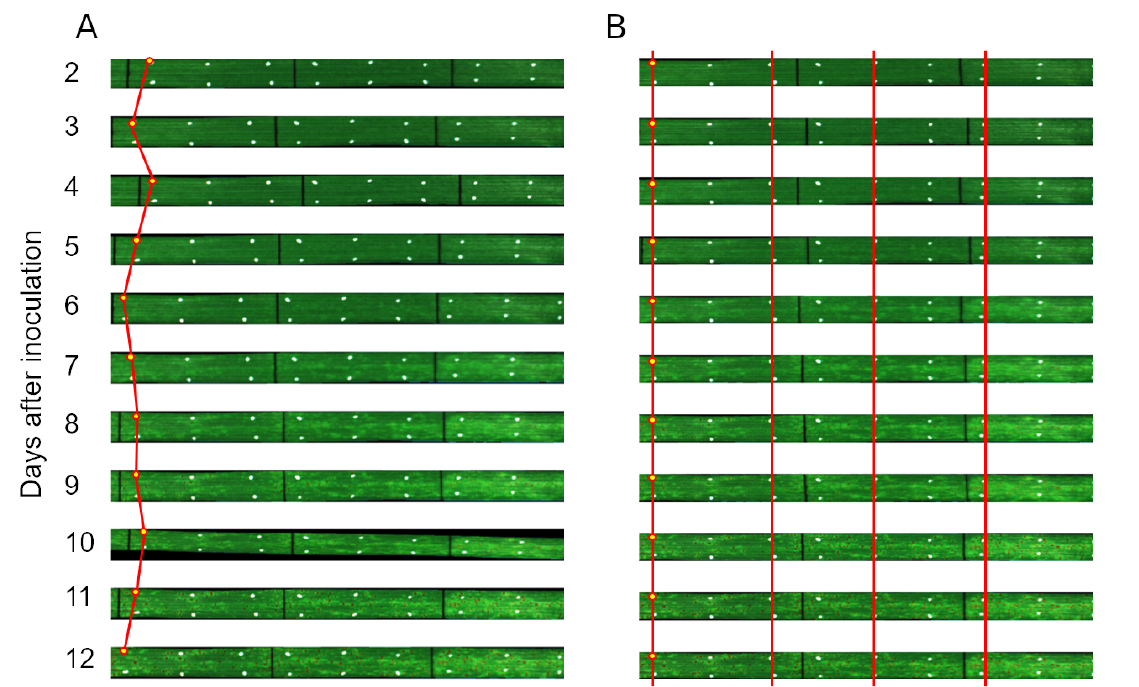
Figure 4. Effect of the spatial referencing. ( A ) shows the time series of unaligned hyperspectral images and ( B ) the same time series after the application of the proposed algorithm. To illustrate the result, identical points within the images were connected by red